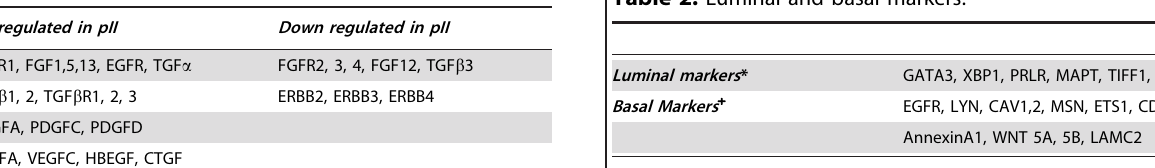
Table 2. Luminal and basal